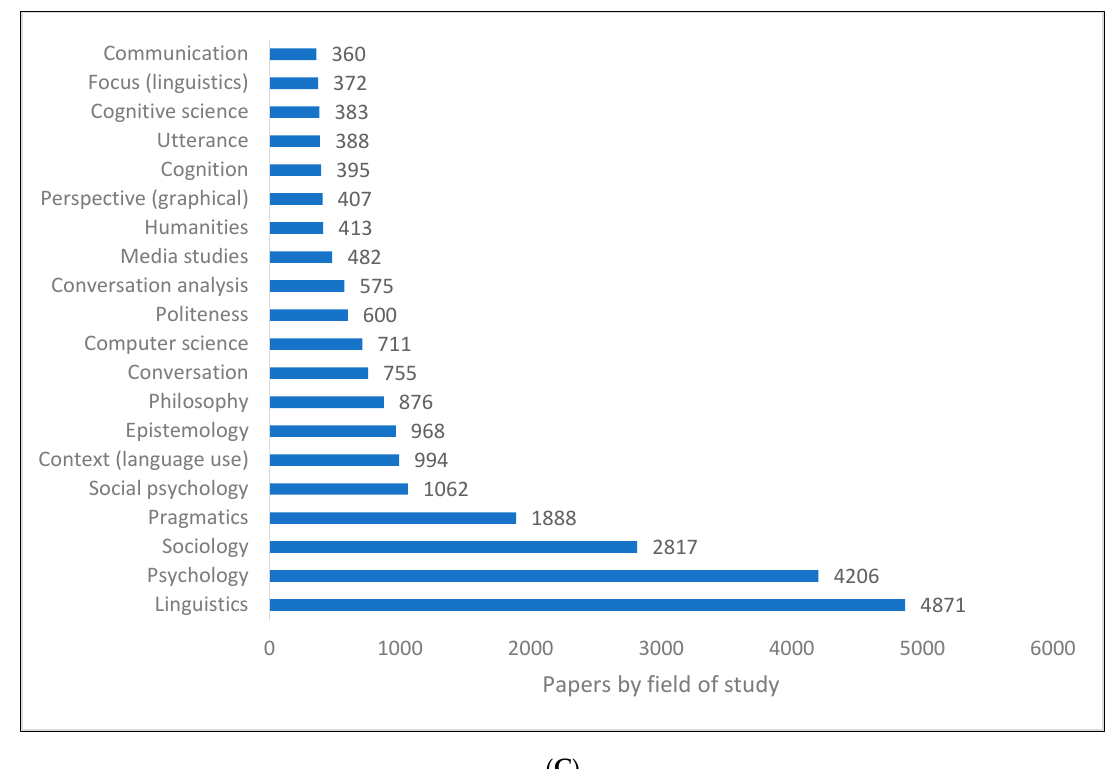
Figure 6. Pragmatics knowledge production size by research area. ( A ) (Scopus). ( B ) (WOS). ( C ) (Lens).